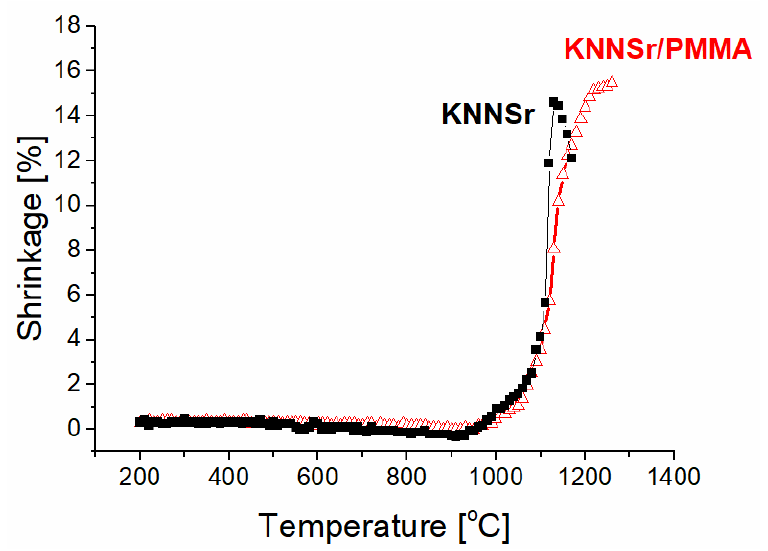
Figure 3. Shrinkage–temperature curve for KNNSr and KNNSr/PMMA. The KNNSr/PMMA pow- der compact was preheated at 350 °C.